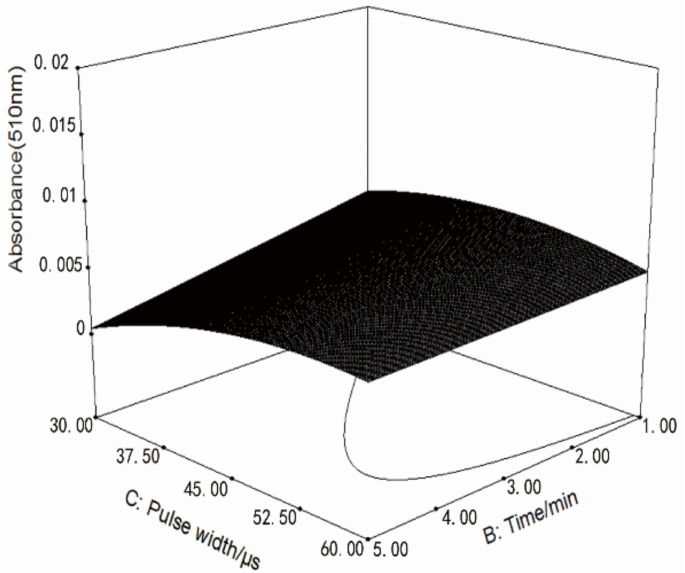
Figure 7. Response surface analysis of processing time and pulse